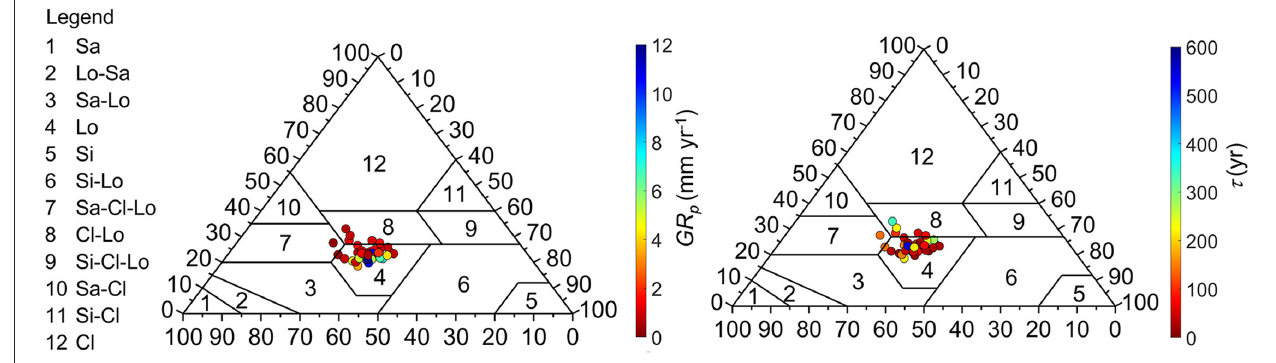
FIGURE 8 | GR p values and τ values in the soil texture distribution (Sa, sand; Si, silt; Lo, loam; Cl, clay) over the 41 experimental soil